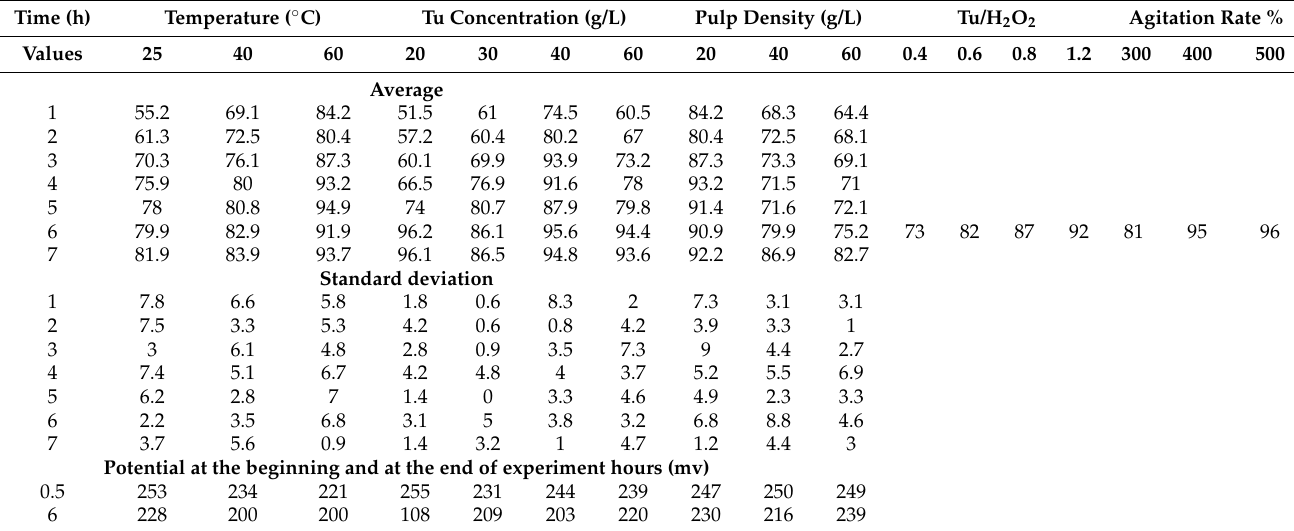
Table 2. Parameters tested in the acidified thiourea leaching tests, leaching conditions, Au recoveries at pH: